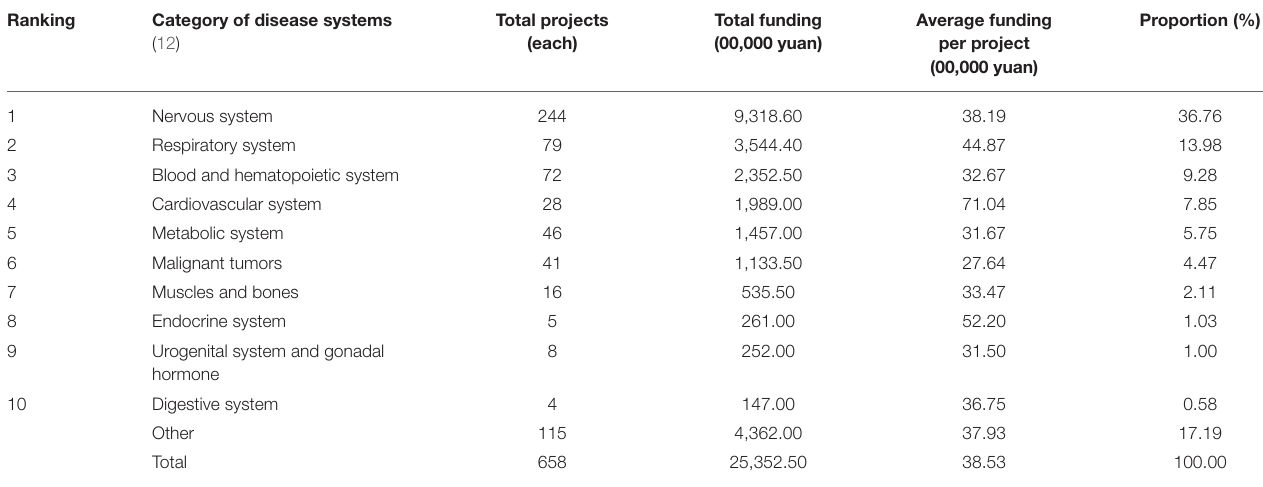
TABLE 3 | R&D input in rare diseases by NSFC by the categories of disease systems. Ranking Category of disease systems